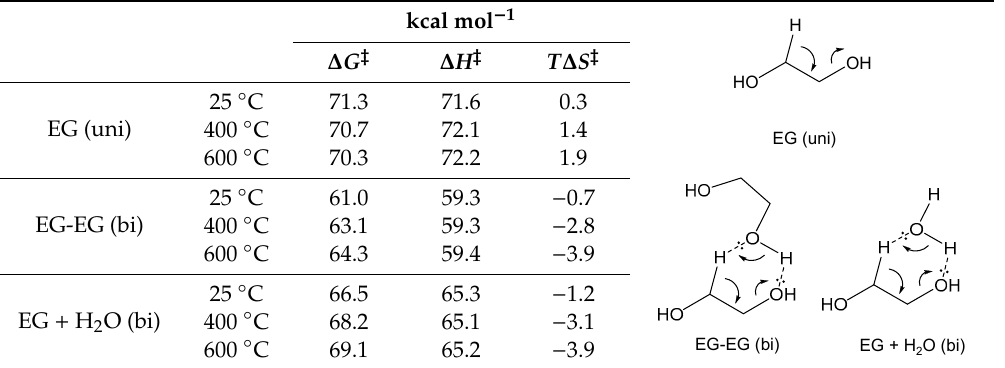
Table 3. The ∆ G ‡ , ∆ H ‡ , and T ∆ S ‡ values (kcal mol − 1 ) calculated for the keto–enol tautomerization of 1,3-dihydroxyacetone (DHA) by assuming the unimolecular (uni) and bimolecular (bi, DHA-DHA, and DHA-H 2 O) mechanisms at 25, 400, and 600 °C from the minimum energies of the transition states, as calculated at the MP4(SDQ)//DFT(M06-2X) level.